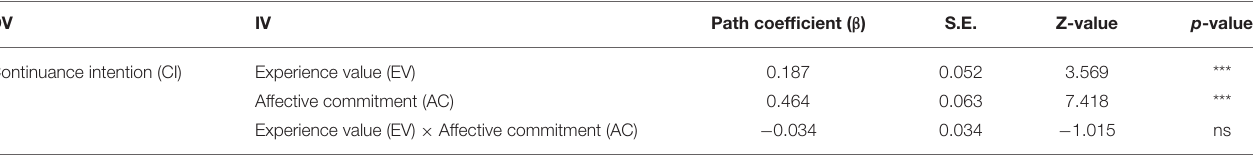
TABLE 6 | The analysis of moderating